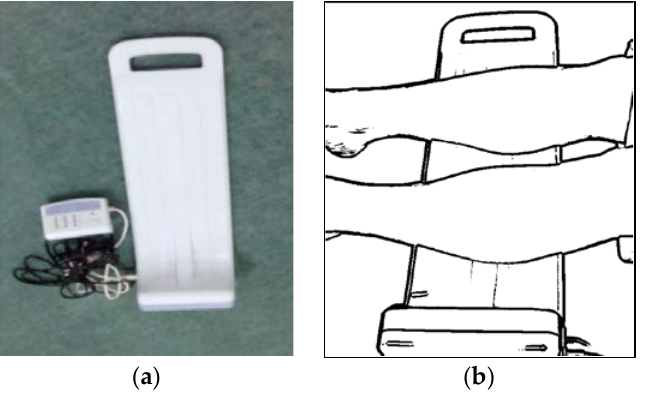
Figure 1. ( a ). RelaWave ®® Matsuda Micronics Vibrators: The blue (bottom) part produces vibration, and the white (top) part distributes the vibration. ( b ). Vibration therapy setup.